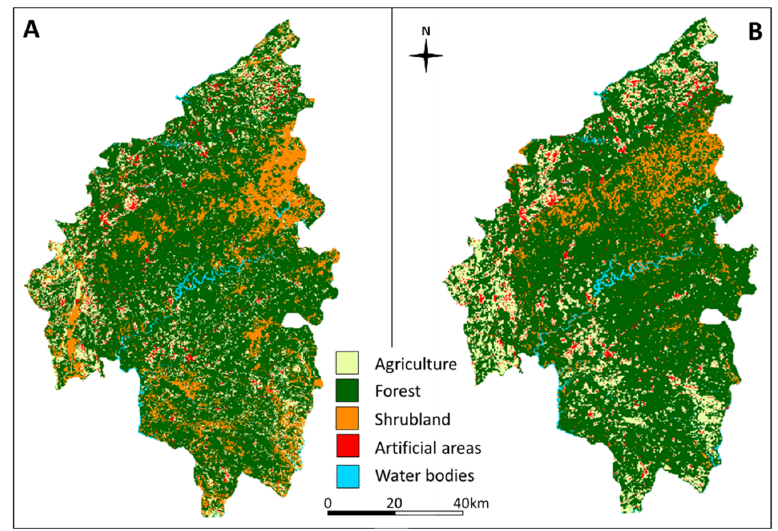
Figure 6. Land use/cover map of the study area in 2018, observed ( A ) and predicted ( B